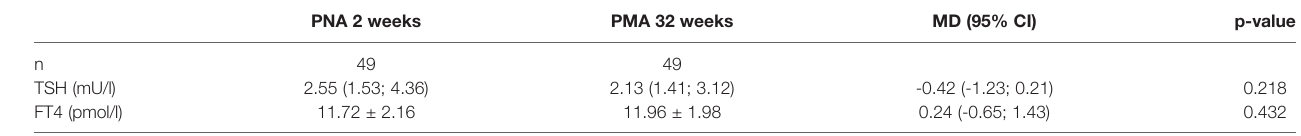
TABLE 3 | Comparison of TSH and FT4 according to PNA 2 weeks and PMA 32 weeks in the 24-28 weeks GA